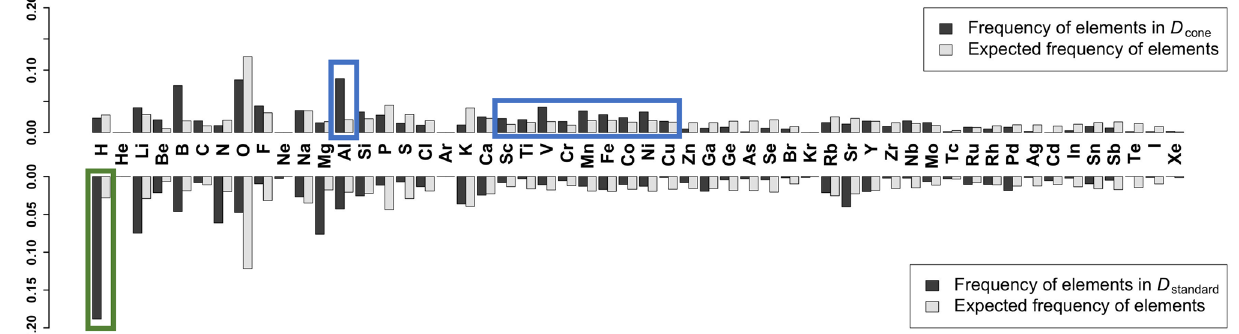
Figure 7. Comparison of the frequencies of chemical elements in D cone (top: black bar chart) and D standard (bottom: black bar chart). White bar charts show the expected frequency calculated with the number of occurrences in the overall